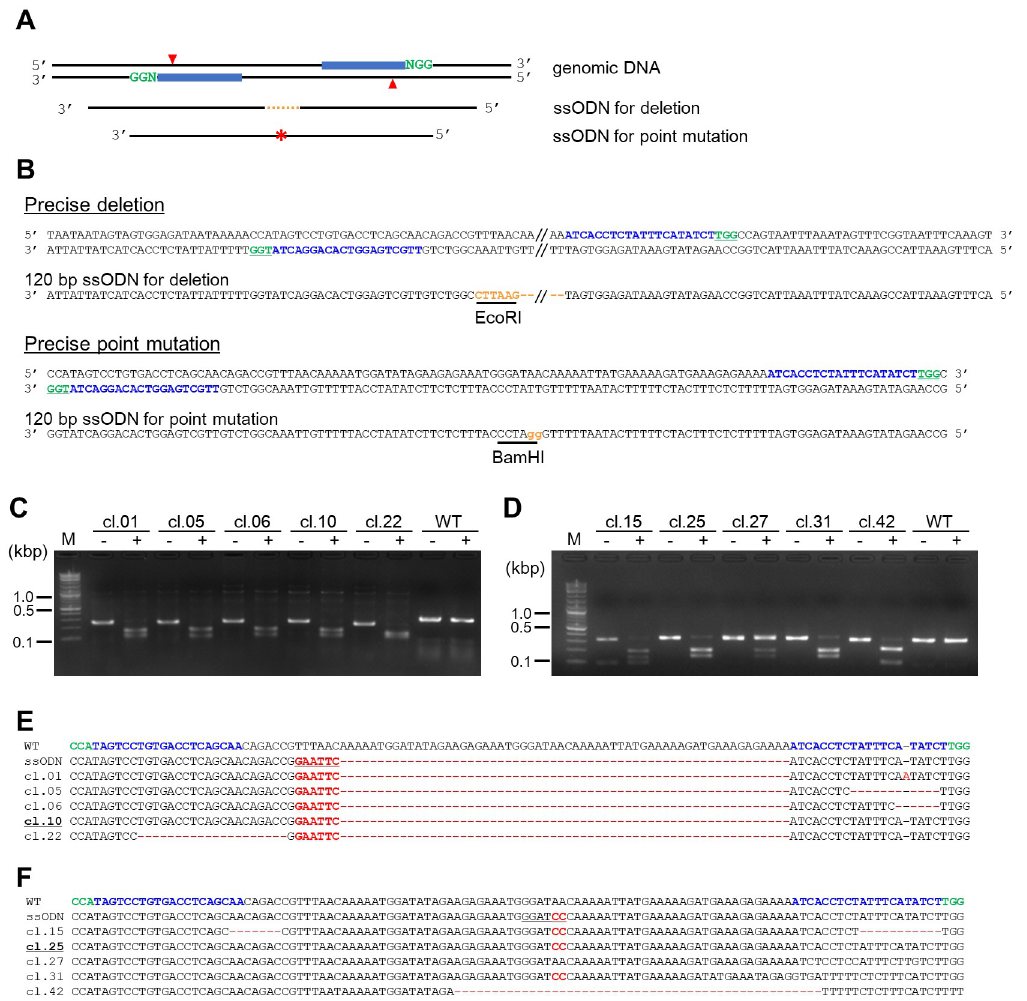
Fig 4. Double nicking-mediated precise genome editing via HDR. (A) Schematic illustration of the precise genome editing approach using paired Cas9 nickases and single-stranded oligonucleotides (ssODNs). Point mutations and deletions are marked by orange broken lines and asterisk, respectively. (B) The sequences used as the ssODN templates. A 66 nt deletion and EcoRI restriction site are shown in orange. Point mutations are indicated by orange lowercase letters and the BamHI site is underlined. (C, D) PCR and restriction enzyme analysis of individual clones. PCR products before (-) and after digestion with the appropriate restriction enzyme (+) are shown. (E, F) The wild-type and mutated pkaC sequences. Target sequences are blue and mutations are in